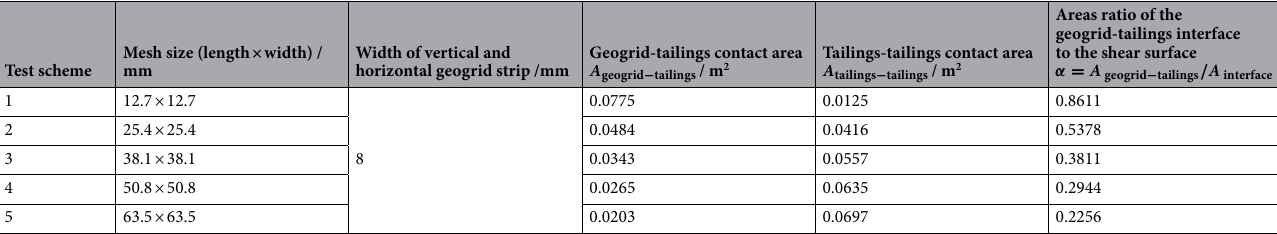
Table 3. Mesh size and corresponding data of geogrid under different test schemes.